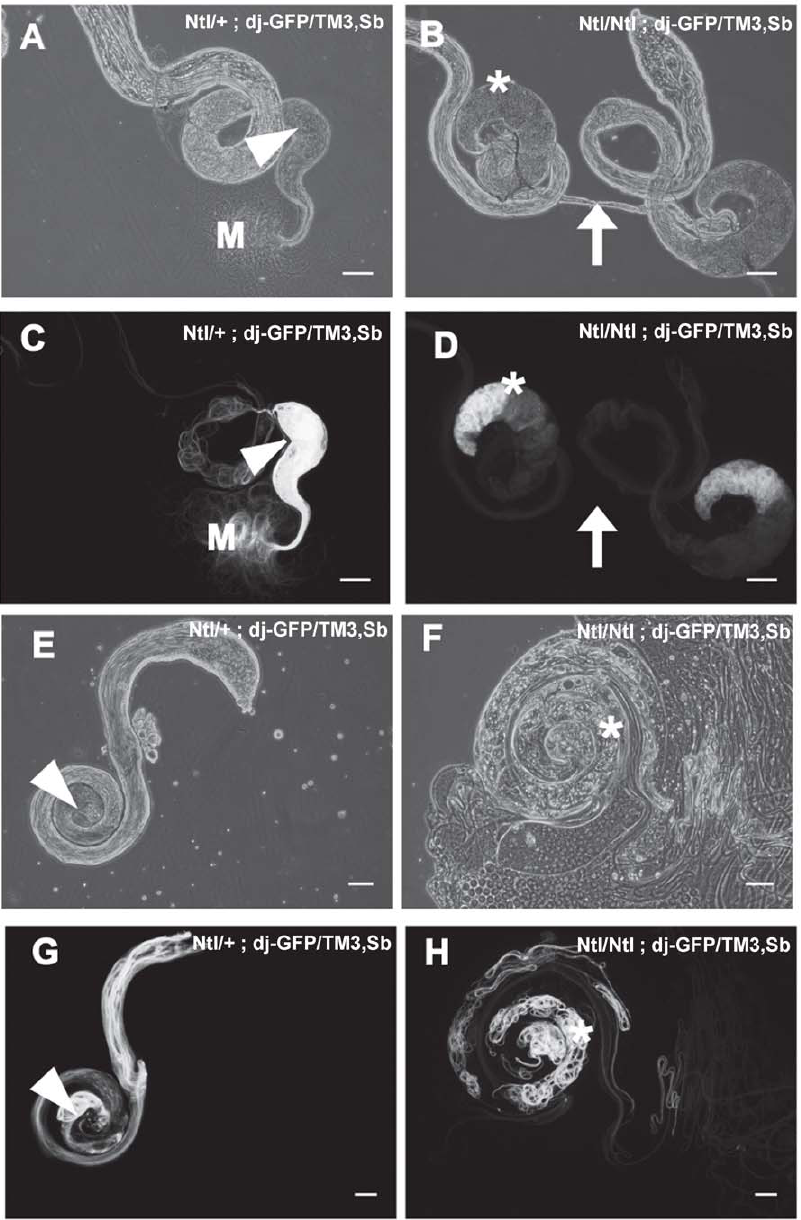
Figure 4. Ntl mutant sperm are immotile and are not transferred into seminal vesicles. Panels A, B, E, and F: Phase contrast images of testes from Ntl + (A, E) and Ntl - (B, F) males. The major phenotypic feature of the mutants is the accumulation of coiled cysts at the base of the testis (asterisks), and the empty/shrunken state of the seminal vesicle (arrows). Panels, C, D, G, and H: don juan- GFP fluorescence images corresponding to phase images immediately above them, showing the disposition of elongated cysts and mature sperm in the testis and seminal vesicle. Note the complete absence of fluorescence from the seminal vesicle of Ntl/Ntl mutants (arrows) compared to the accumulated fluorescence in wild type seminal vesicles (arrowheads), and accumulation of coiled cysts in the base of the mutant testes (asterisks). In panels A and C, the letter M demotes dense masses of mature motile sperm which is not seen in the mutants. Left hand panels: wild type ( Ntl/ + ); right hand panels: Ntl 129A / Ntl 129A mutants. Bars, 20 m m.